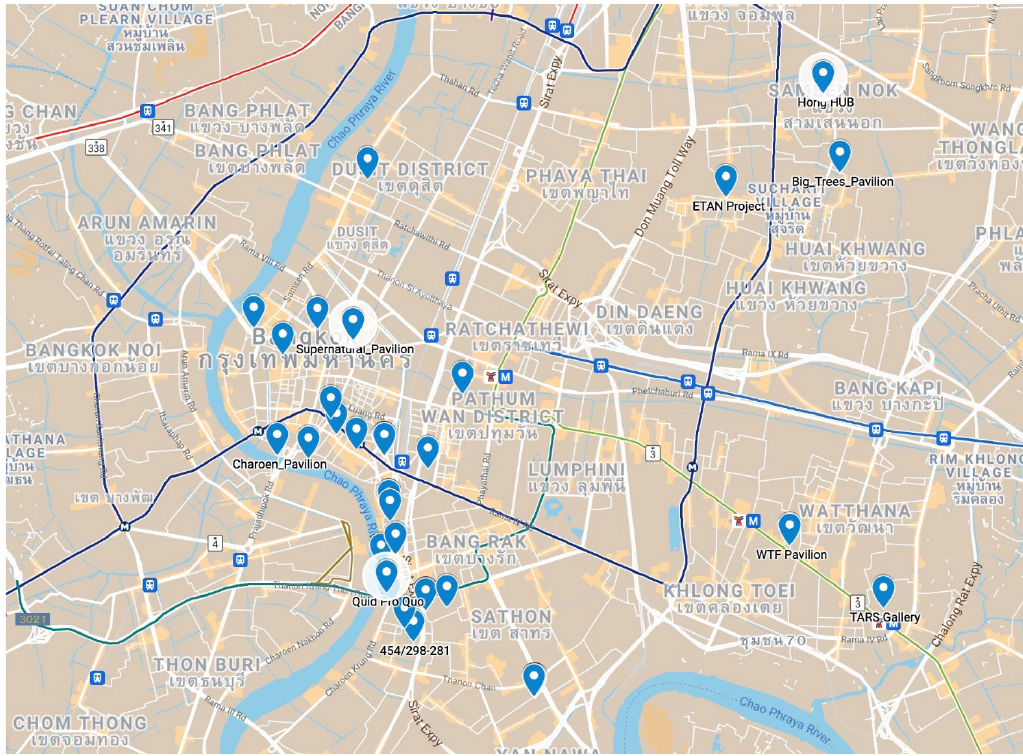
Figure 2. Overview of the location of Bangkok Biennial 2018 pavilions in central Bangkok, with three discussed pavilions